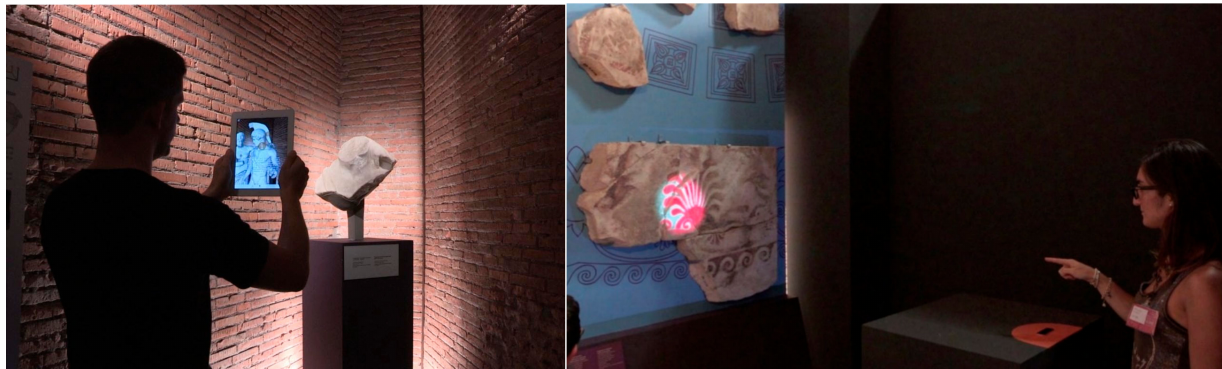
Figure 15. Digital installation used in the Keys2Rome exhibition to improve object legibility through interactive real-time virtual restoration. ( Left ) App for smart devices based on augmented reality. ( Right ) Interactive installation based on projection